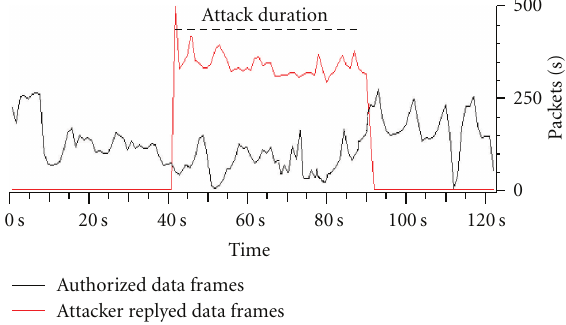
Figure 12: Wireless network performance during data replay